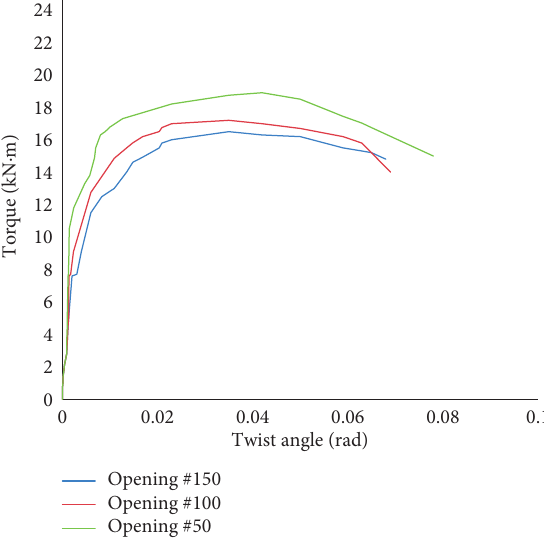
Figure 11: Torque-twist angle relationship of circle hollow cross-